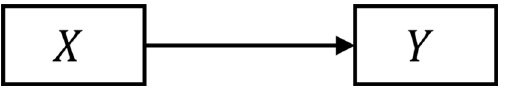
Note. The regression coefficient corresponds to the slope of the regression